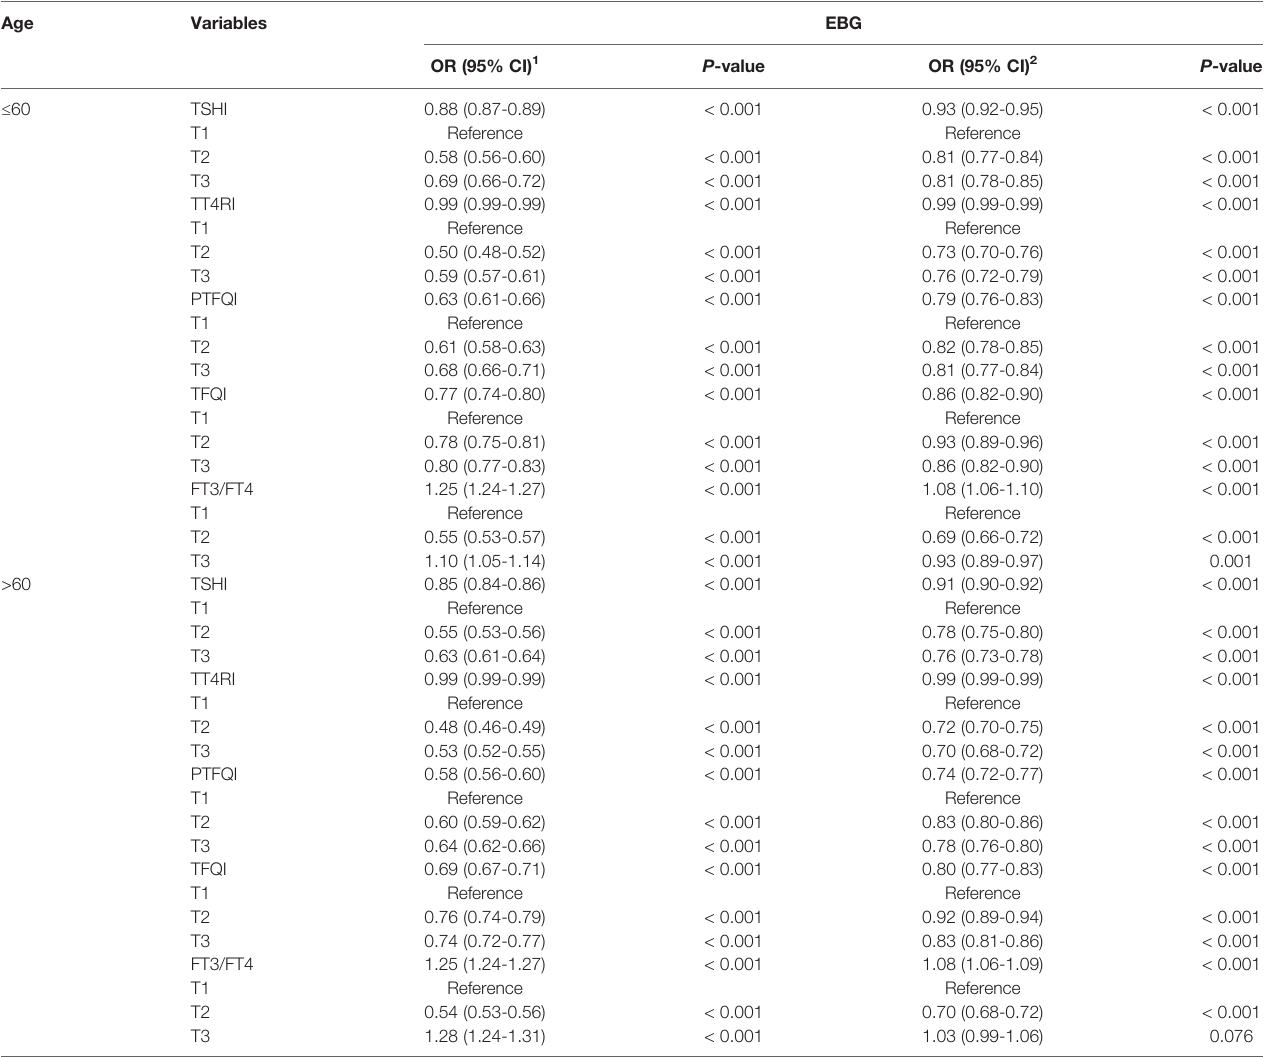
TABLE 4 | Relationship between thyroid hormone sensitivity and EBG in different age strati fi cation. Age